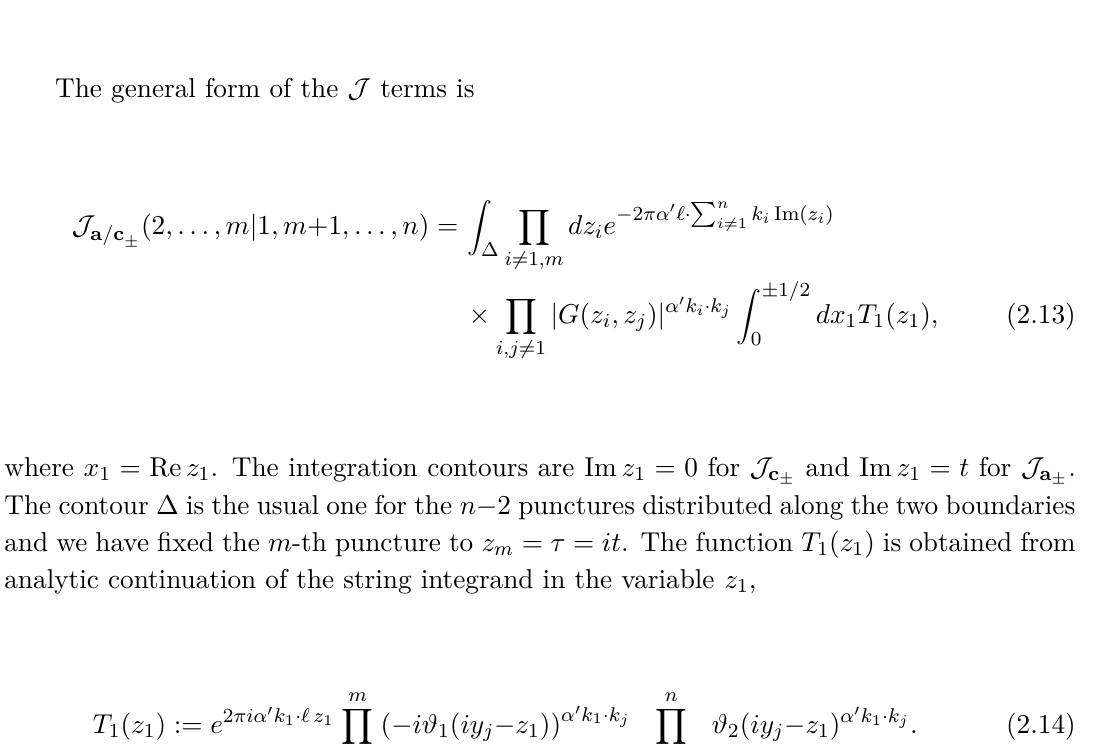
Figure 4 . Illustration of monodromies relations coming from the vanishing of an integral around the closed blue contour,cv for a generic non-planar amplitude. Left: open string annulus, with punctures. Red line: A -cycle, along which the Riemann surface is cut, defines where the loop momentum ‘ µ = R ∂X µ is measured. Blue cycle: the contour over which the puncture z 1 is A being integrated. As no pole exist in the bulk, the full integral vanishes. Each segment along the boundary. Right: rectangle representation of the annulus, with depictions of contours for z 1 . The I contours are usual open string boundary contours, the J are bulk